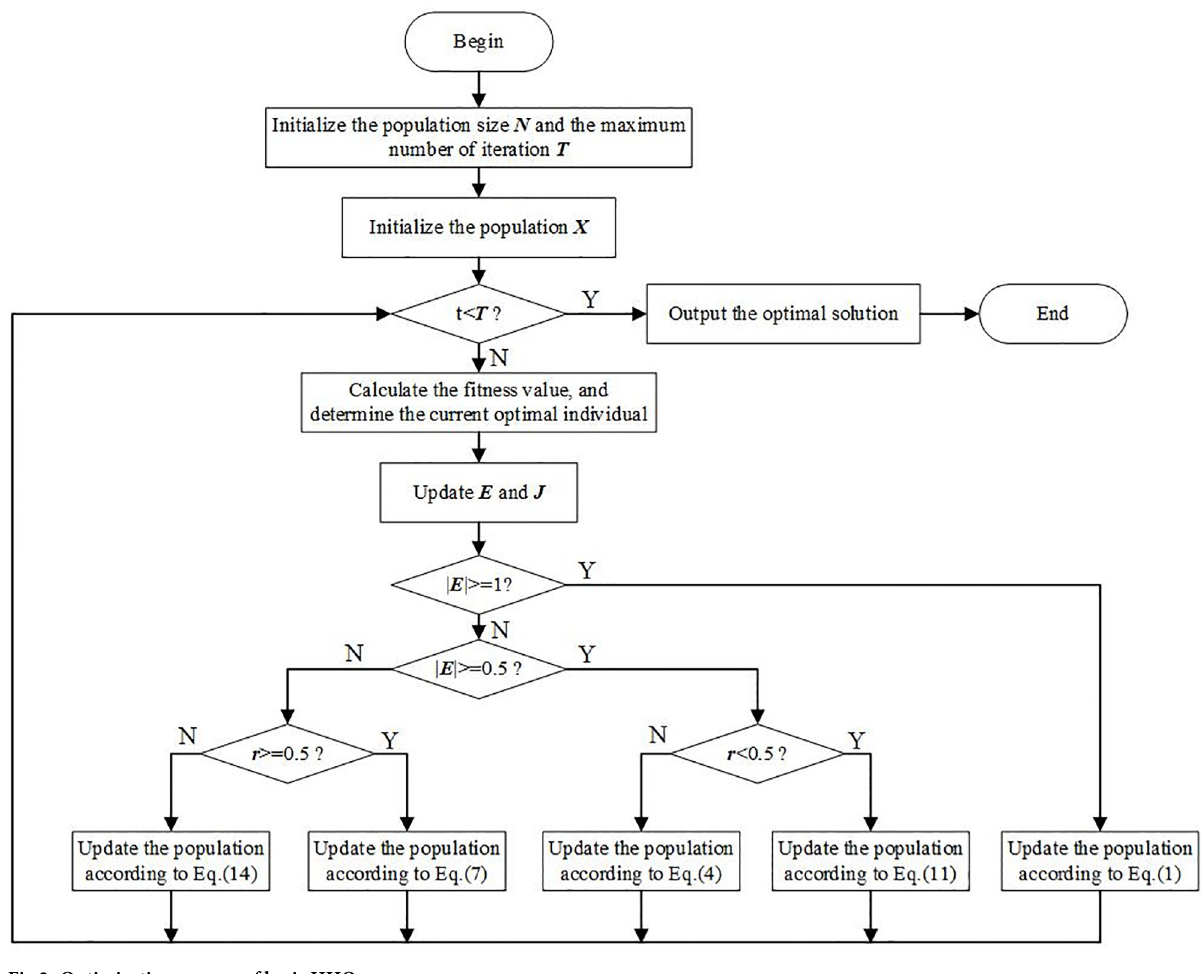
Fig 2. Optimization process of basic